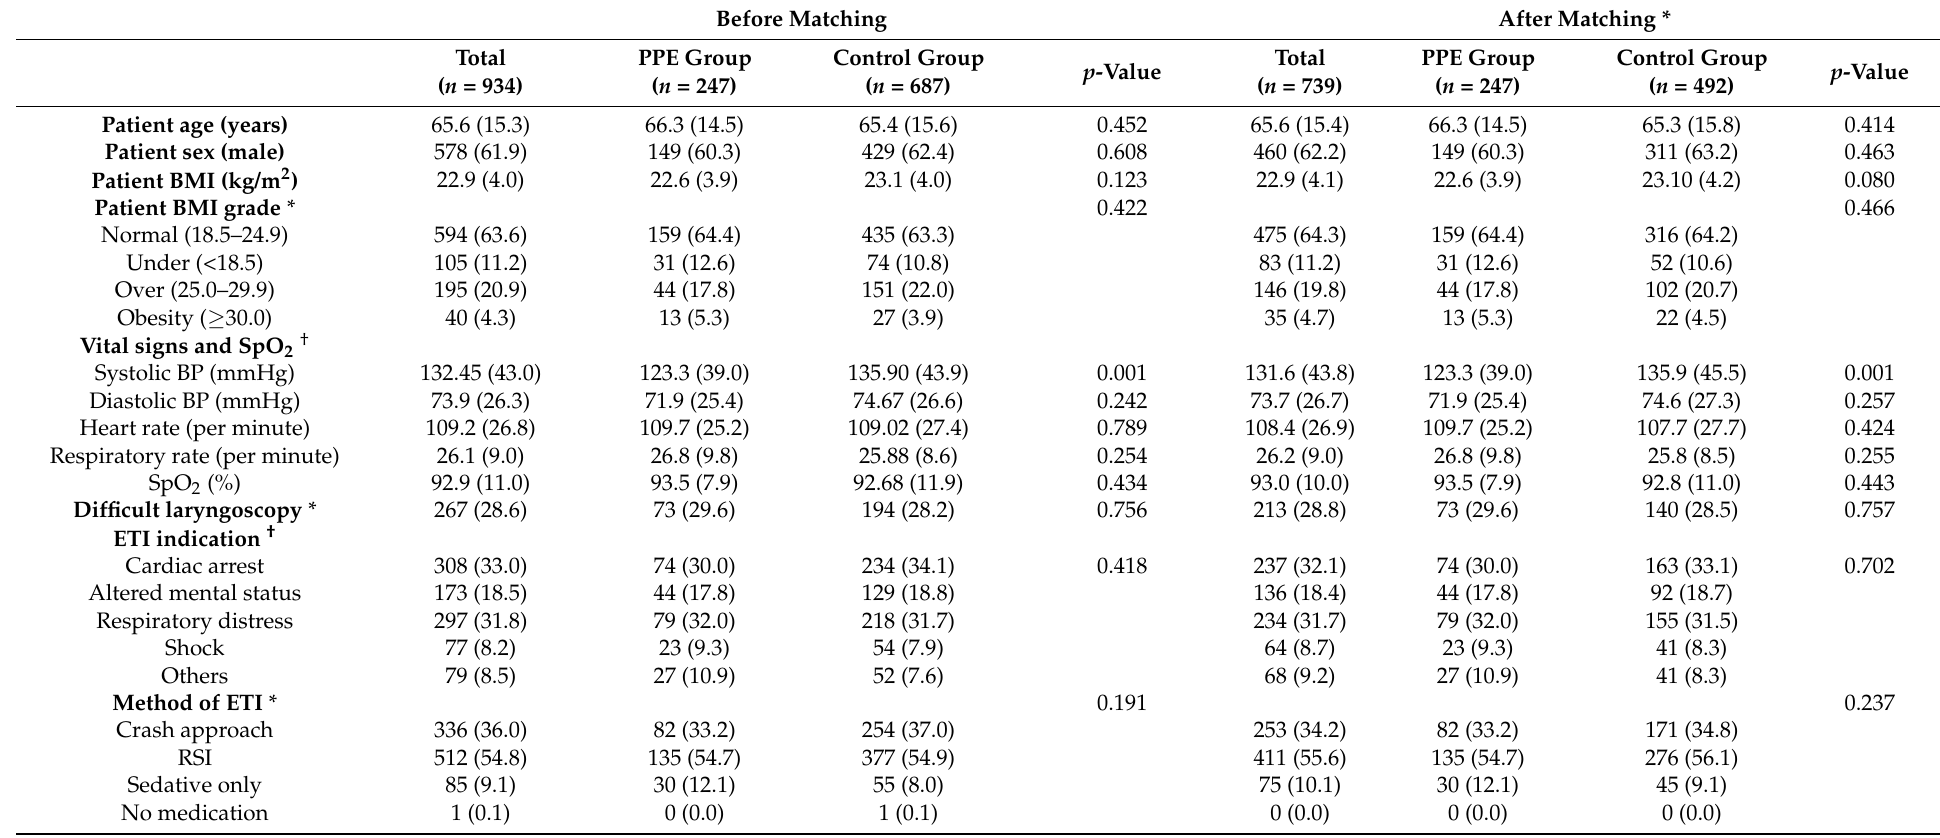
Table 1. Baseline characteristics of the patients and ETI